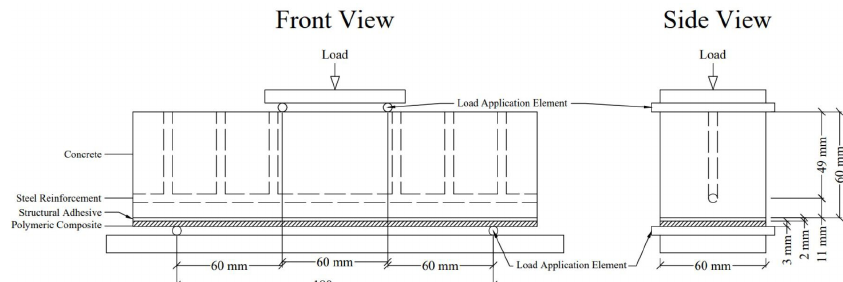
Figure 6. Conditions of the bending test on hybrid